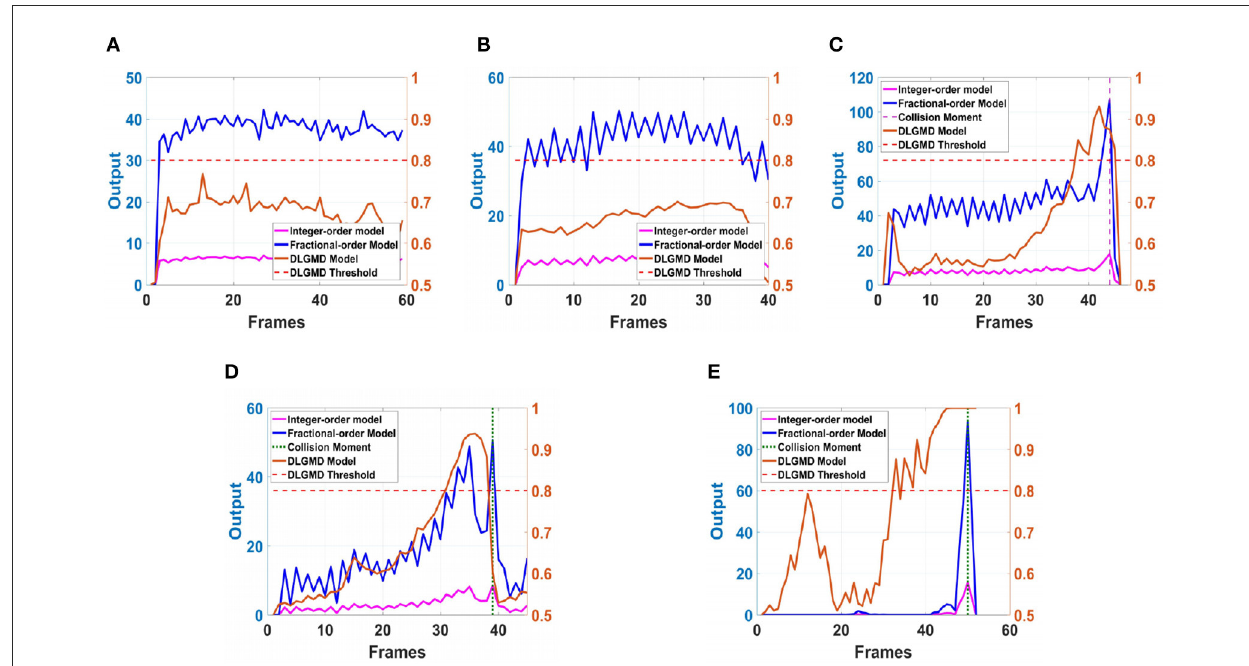
FIGURE12 The neural network output of different models in ball motion video. (A) The ball moves to the left. (B) The ball moves to the right. (C) The ball moves downwards to the left. (D) The ball moves downwards to the right. (E) The ball is looming moving towards the